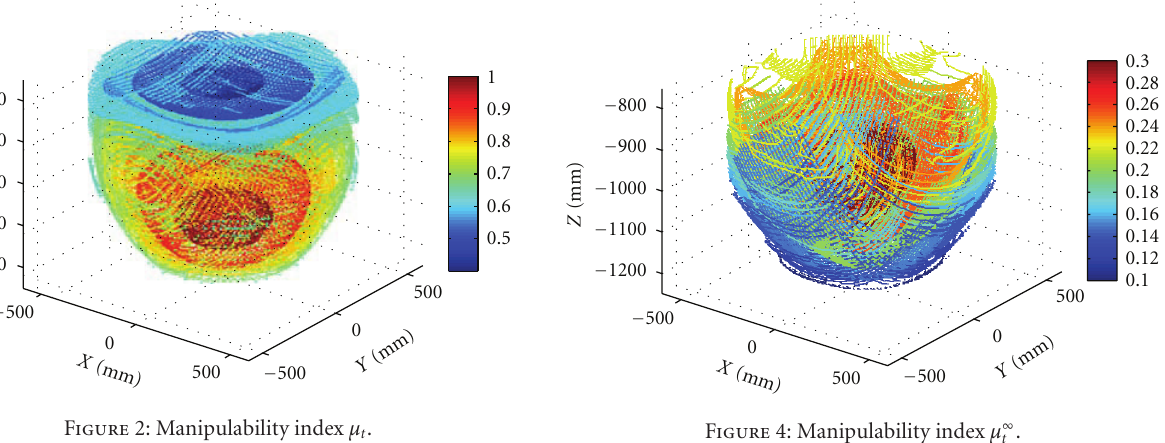
Figure 4: Manipulability index μ ∞ t .